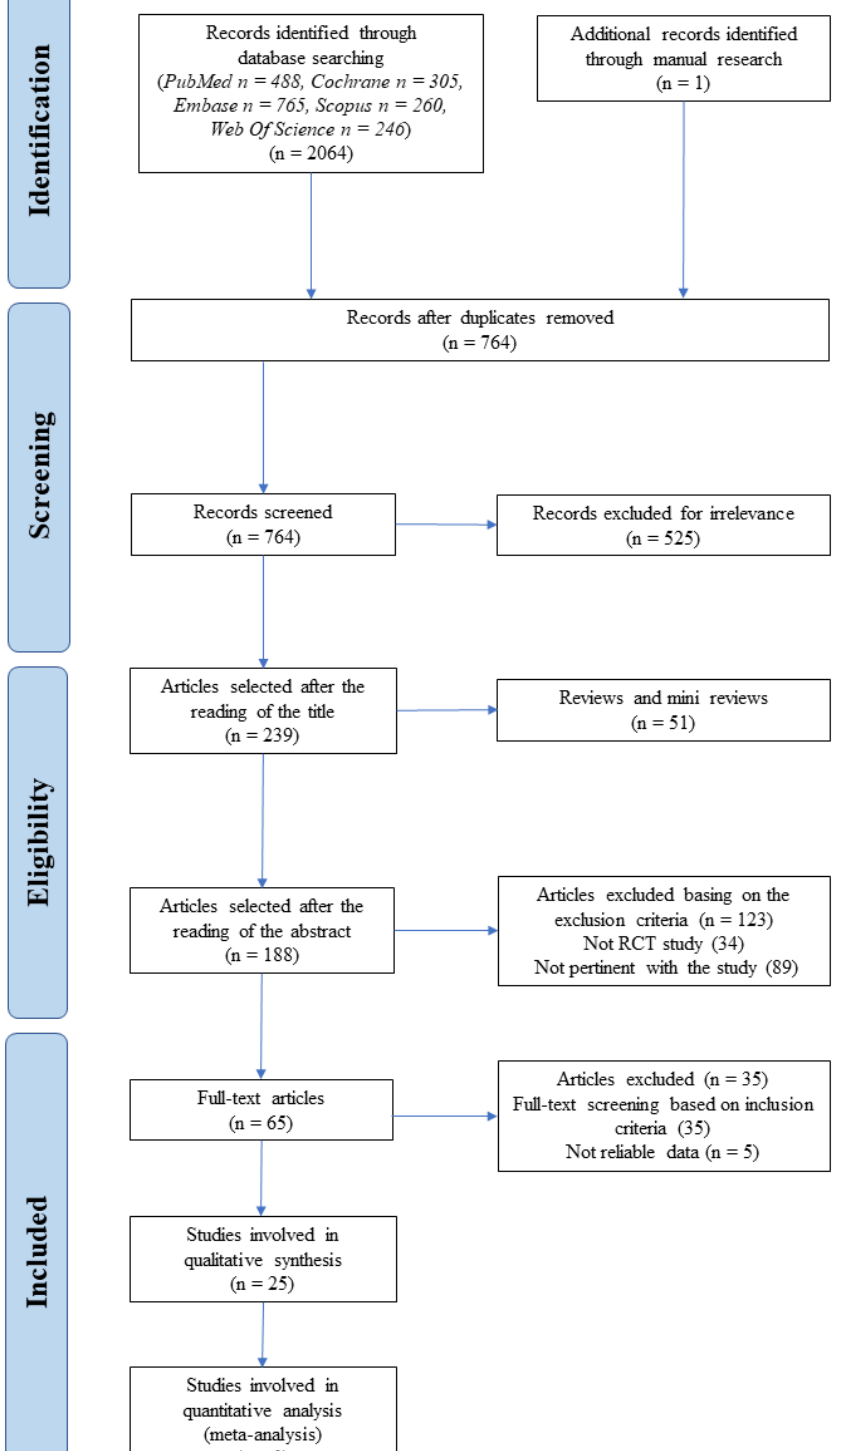
Figure 2. PRISMA flowchart for studies selection. The reasons for excluding articles were the following: non-RCT studies, no furcation defects, no OFD as control group, animal and in vitro studies, irrelevant subjects, no periodontal patients and/or regeneration, peri-implant treatment, short follow-up period, unreliable data and language.